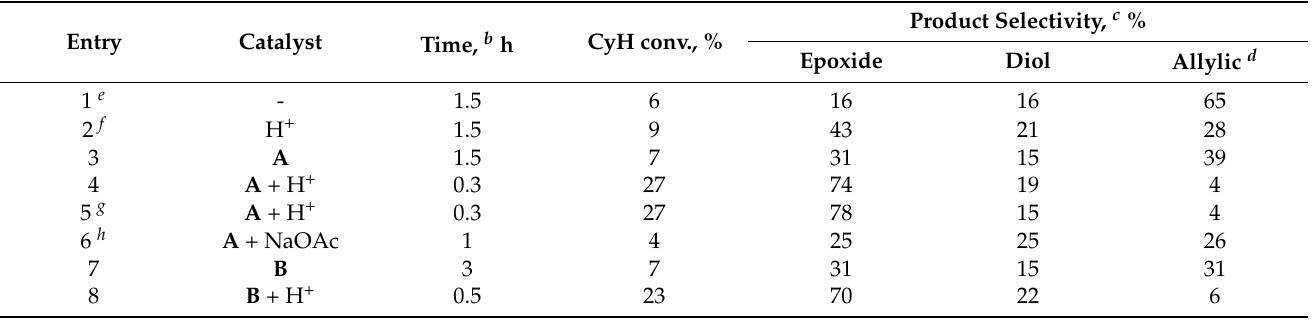
Table 2. Cyclohexene oxidation with H 2 O 2 in the presence of various Zr-Si catalysts a